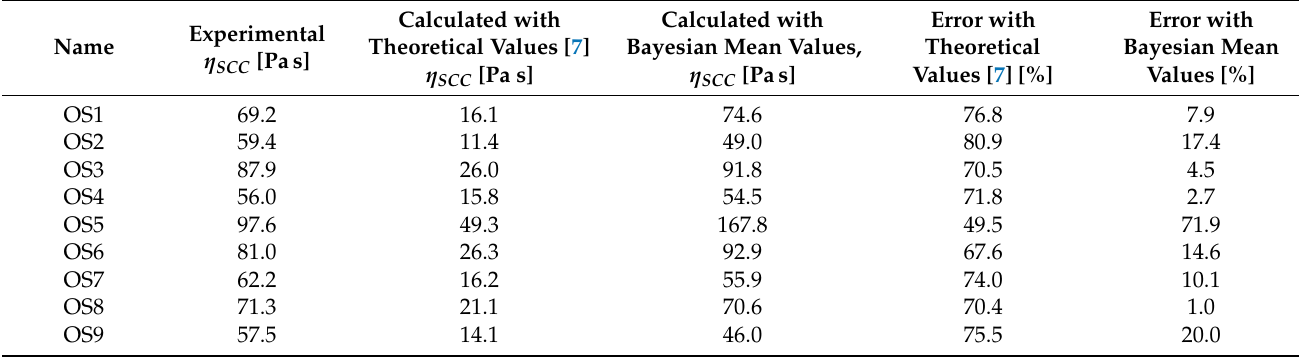
Table 10. Comparison between experimental values, models, and error estimated for self-compacting concrete (Grünewald